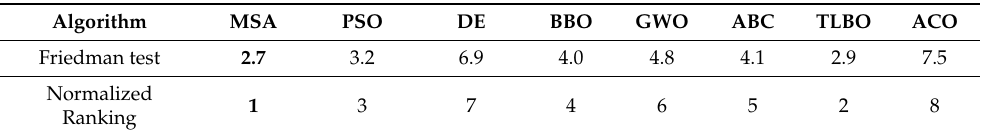
Table 2. Ranking score of the MSA against 7 popular meta-heuristic algorithms performance results based on Friedman’s non-parametric test (the best values are indicated in